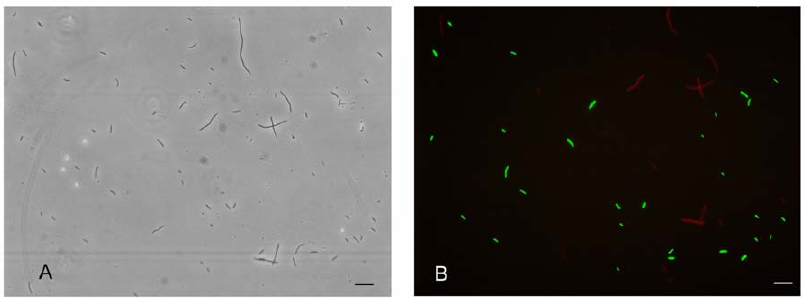
Figure 6. Response of mixed culture IPTG- and aTc-sensitive nanorecorders. Visible light (A) and false coloured fluorescence microscopy image of a mixed culture of PB103:pTAK117-minC (labeled green) and PB103:pIKE107-RFP-minC (labeled red). The culture was exposed to a 15 min, 0.25 nM anhydrotetracycline (aTc) pulse and after 2 h, the culture was exposed to a 30 min, 10 mM IPTG pulse. The culture was effectively grown for 90 min post-IPTG exposure and 4 h post-aTc exposure and imaged using TRITC and FITC filters. Scale bar is 50 m